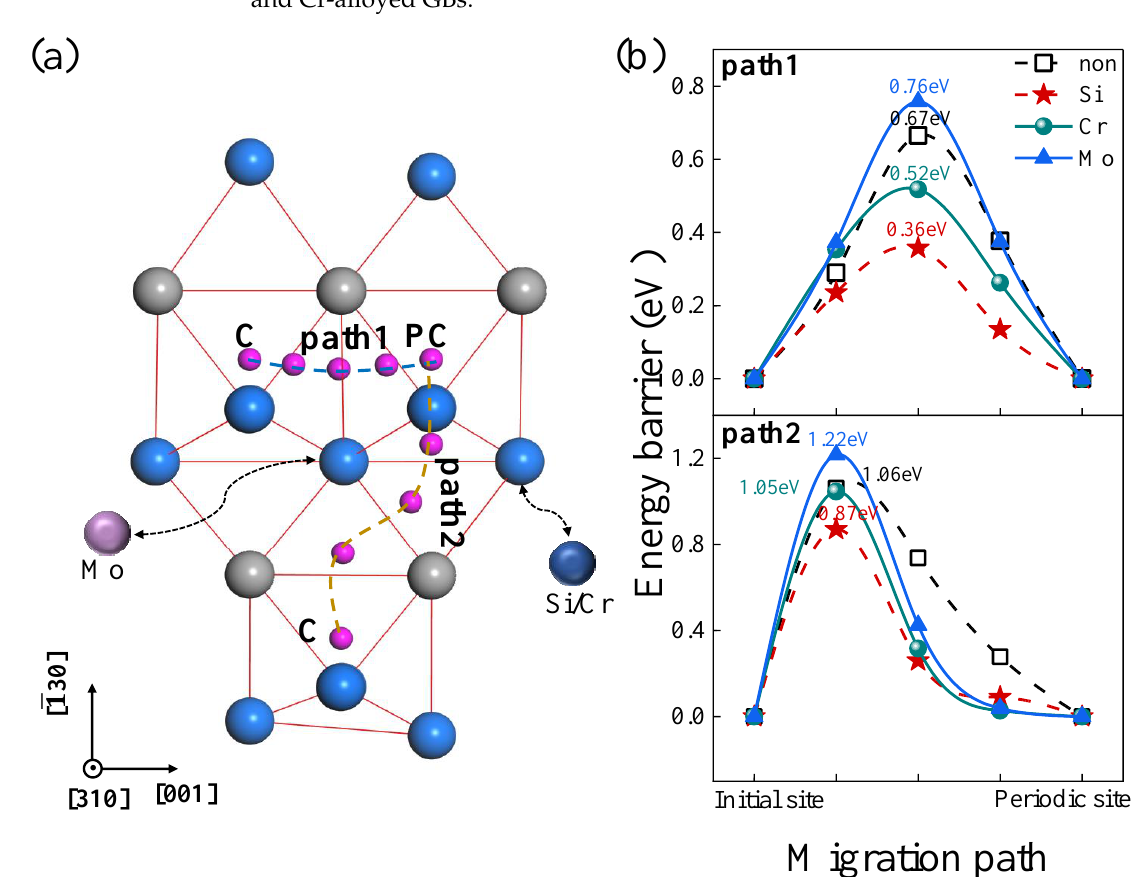
Figure 4. ( a ) The migration paths of an O atom at the GB of Fe Σ5 (310). The C and PC sites represent the most stable positions of the O atom at the CTP structure unit, path 1 represents the migration path from C to PC along the [001] direction and is indicated by the blue dashed line, path 2 represents the migration path from PC to C along the [1̅30] direction and is indicated by the yellow dashed line. The dark blue sphere represents the alloying elements Si and Cr, the purple sphere represents the alloying element Mo and the black dotted line indicates that they replace the corresponding Fe atoms. The blue and gray spheres represent Fe atoms, and the pink spheres represent an O atom. ( b ) The migration energy barriers of O atoms on two paths (path 1 and path 2). The black hollow square represents the migration energy barrier of O in the pure Fe grain boundary, the solid red star, cyan sphere and blue triangle represent the migration energy barriers of O in a Fe-GB with Si, Cr and Mo, respectively.